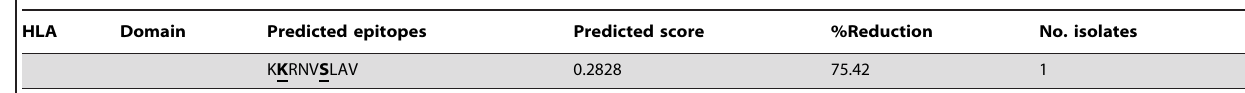
Table S1 Haplotypes of PvTRAP from Thai isolates. Table S2 Characteristics of amino acid substitutions in PvTRAP of worldwide and Thai isolates. Table S3 Minimum number of recombination events (Rm) and recombination sites in the PvTRAP gene of each parasite population in Thailand.